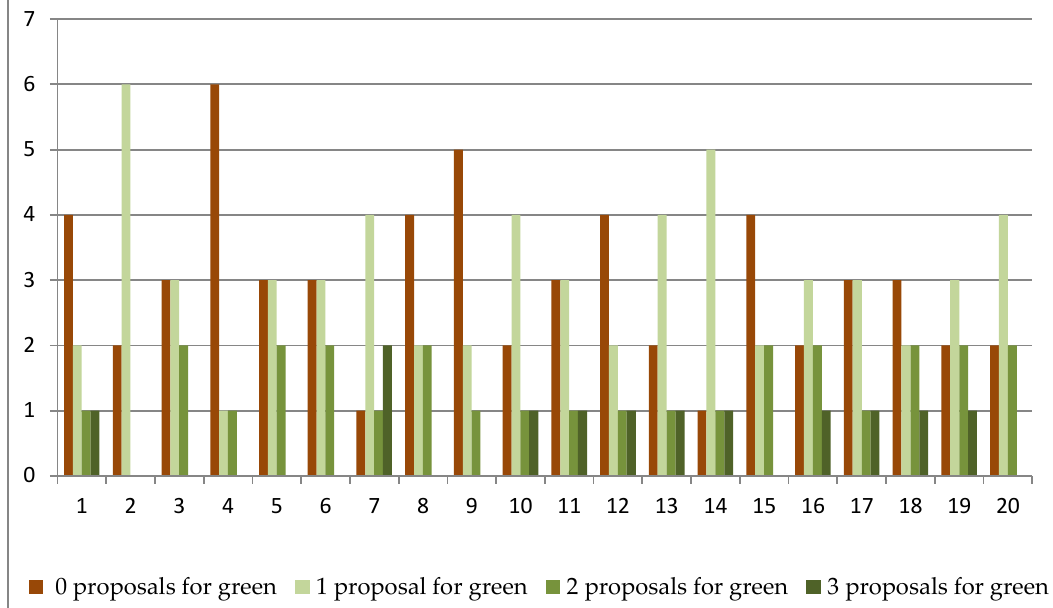
Figure 2. Announcements of green goods in NEUTRAL FRAME Treatment, per period and market.